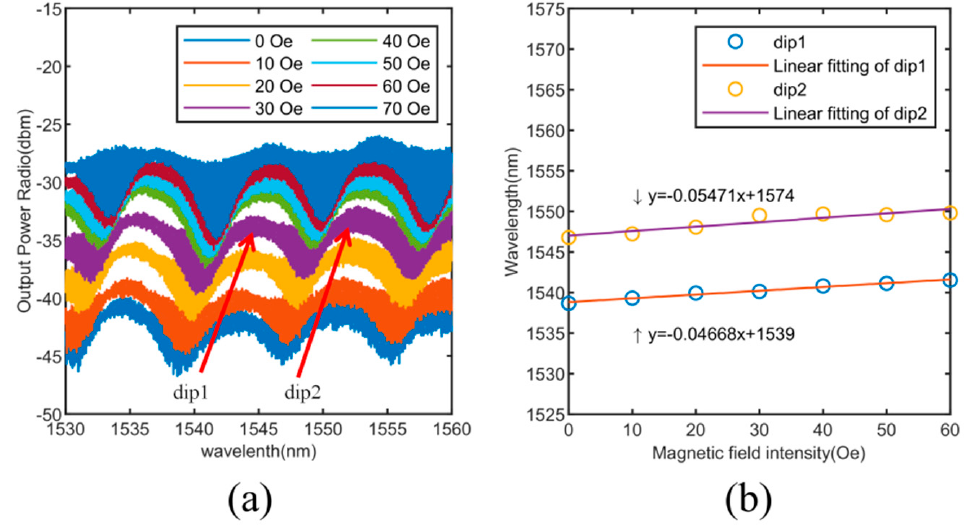
the magnetic field sensitivity of the sample 1 is 46.68 pm/Oe for S B 1 -dip 1 and 54.71 pm/Oe for S B 1 -dip 2 .